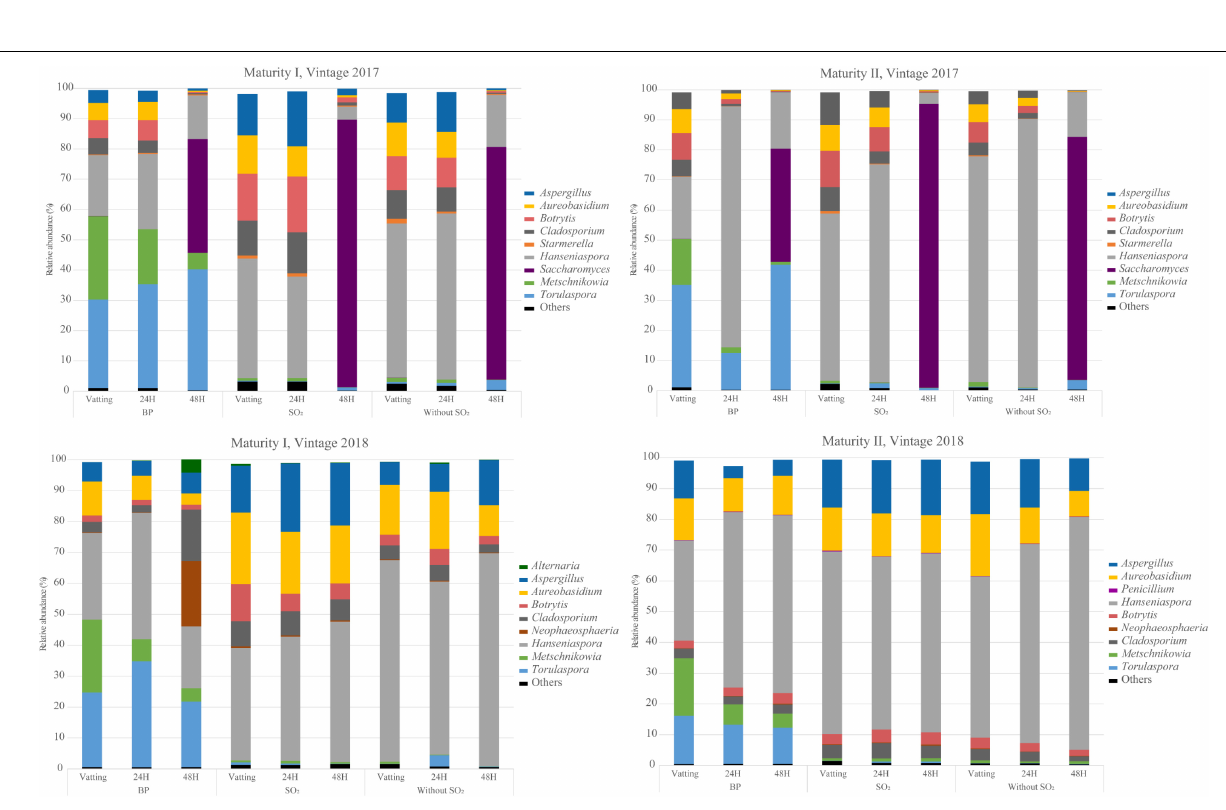
Frontiers in Microbiology |